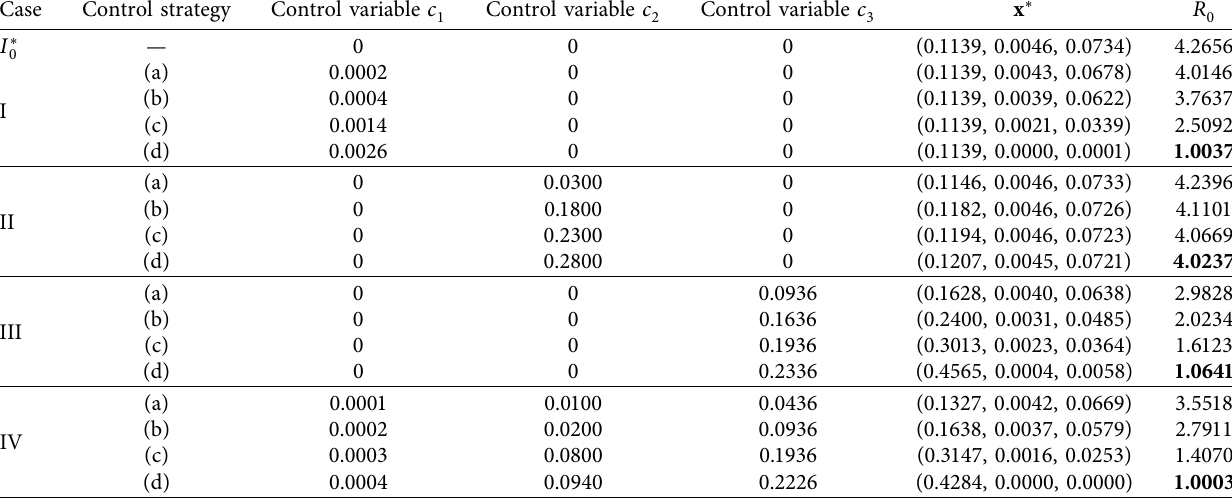
under different control variables c i ( i � 1 , 2 , 3 ) . 0